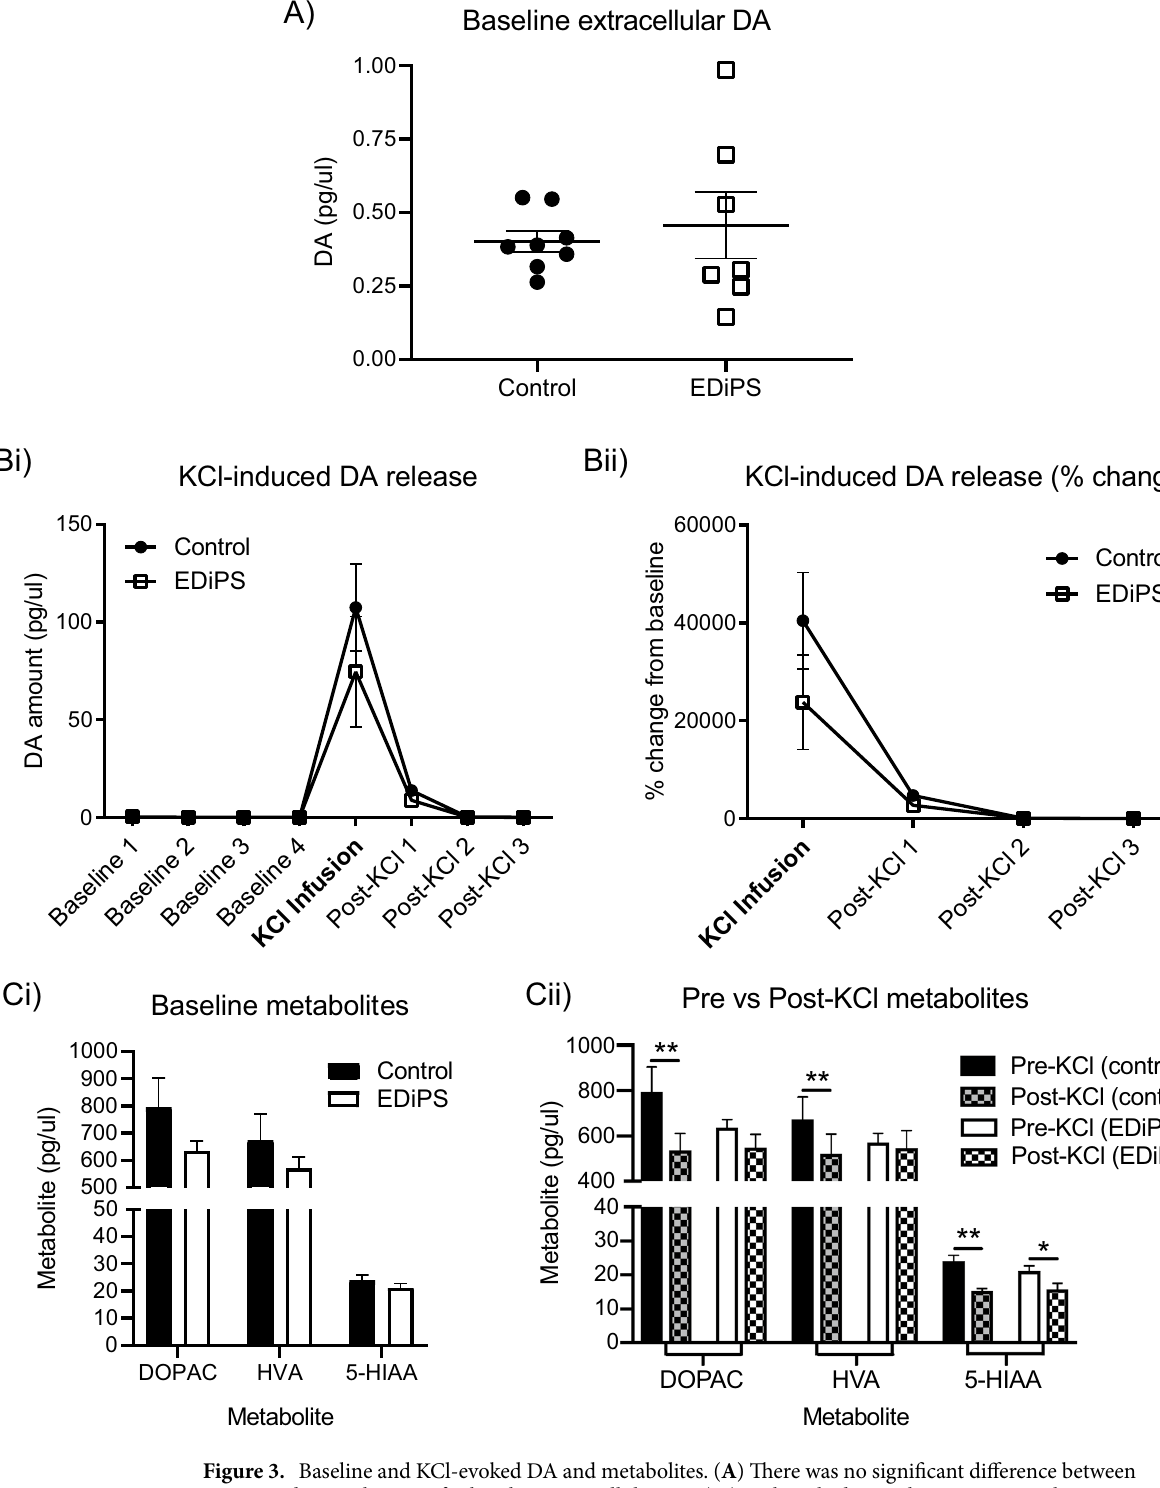
Figure 3. Baseline and KCl-evoked DA and metabolites. ( A ) There was no significant difference between EDiPS and control groups for baseline extracellular DA. ( Bi ) KCl-evoked DA release was normal in EDiPS animals when analysed either as total amount or ( Bii ) as a % change from baseline. ( Ci ) A regular 2-way ANOVA of the baseline levels of each metabolite (the average of the last 2 baseline bins—baseline 3 and baseline 4) indicated no difference for any metabolite between EDiPS and control animals. ( Cii ) Metabolites were also compared pre- and post-KCl infusion. Control animals showed the expected decline in metabolite